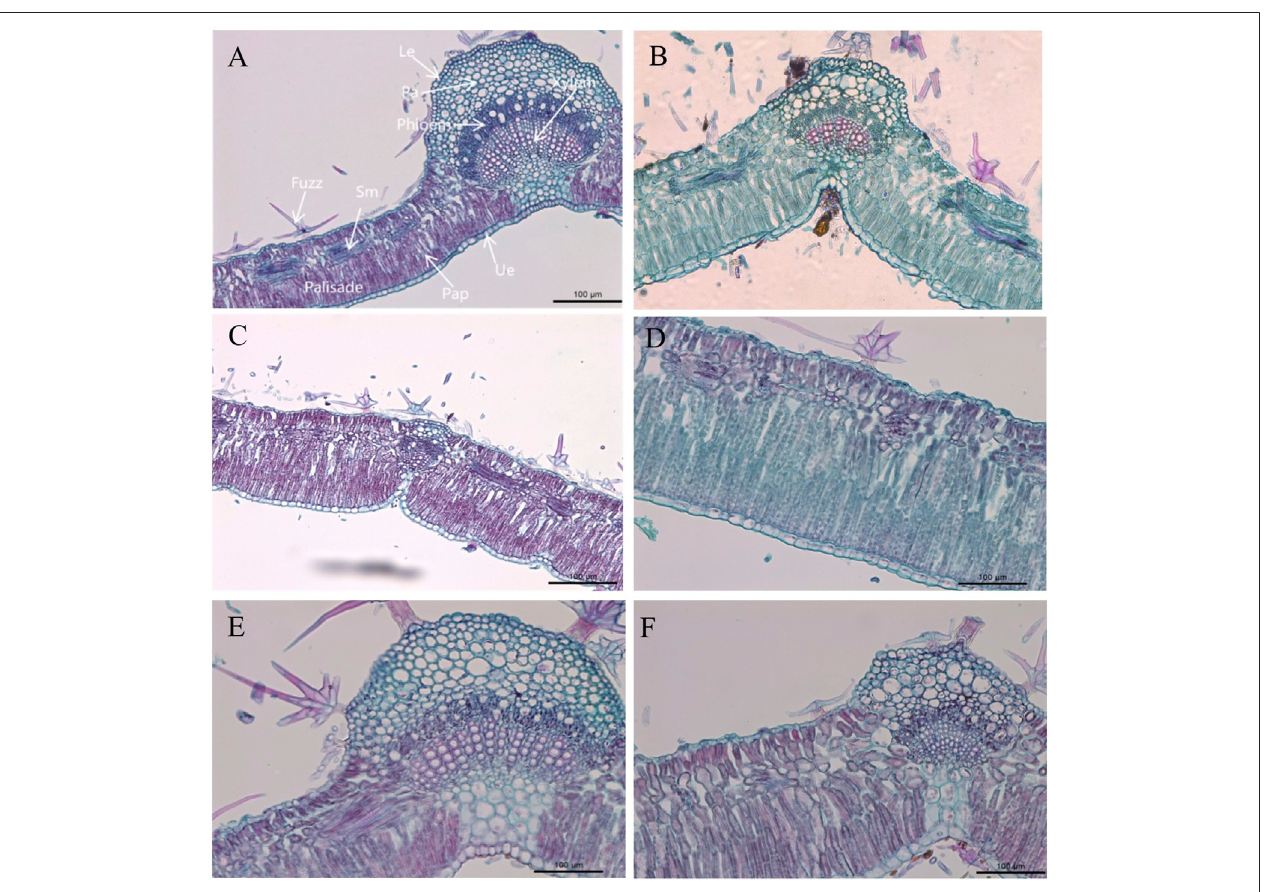
FIGURE 1 | Transverse section of a date palm leaf blade. (A – C) Leaf cross-sections of midrib 10x; (D) . Cross-sections ofmesophyll 20x; (E,F) . Cross-sections of leafveins20x; (A) CK, (B) T1treatment, (C) T5treatment, (D) T6treatmentshowingspongytissuewithobviousfenestration, (E) T8treatmentshowingthin-walledtissue development, (F) T9 treatment showing vascular bundle development. Ue. upper epidermis ; Le. lower epidermis ; Pap. palisade tissue; Sm. spongy tissue.